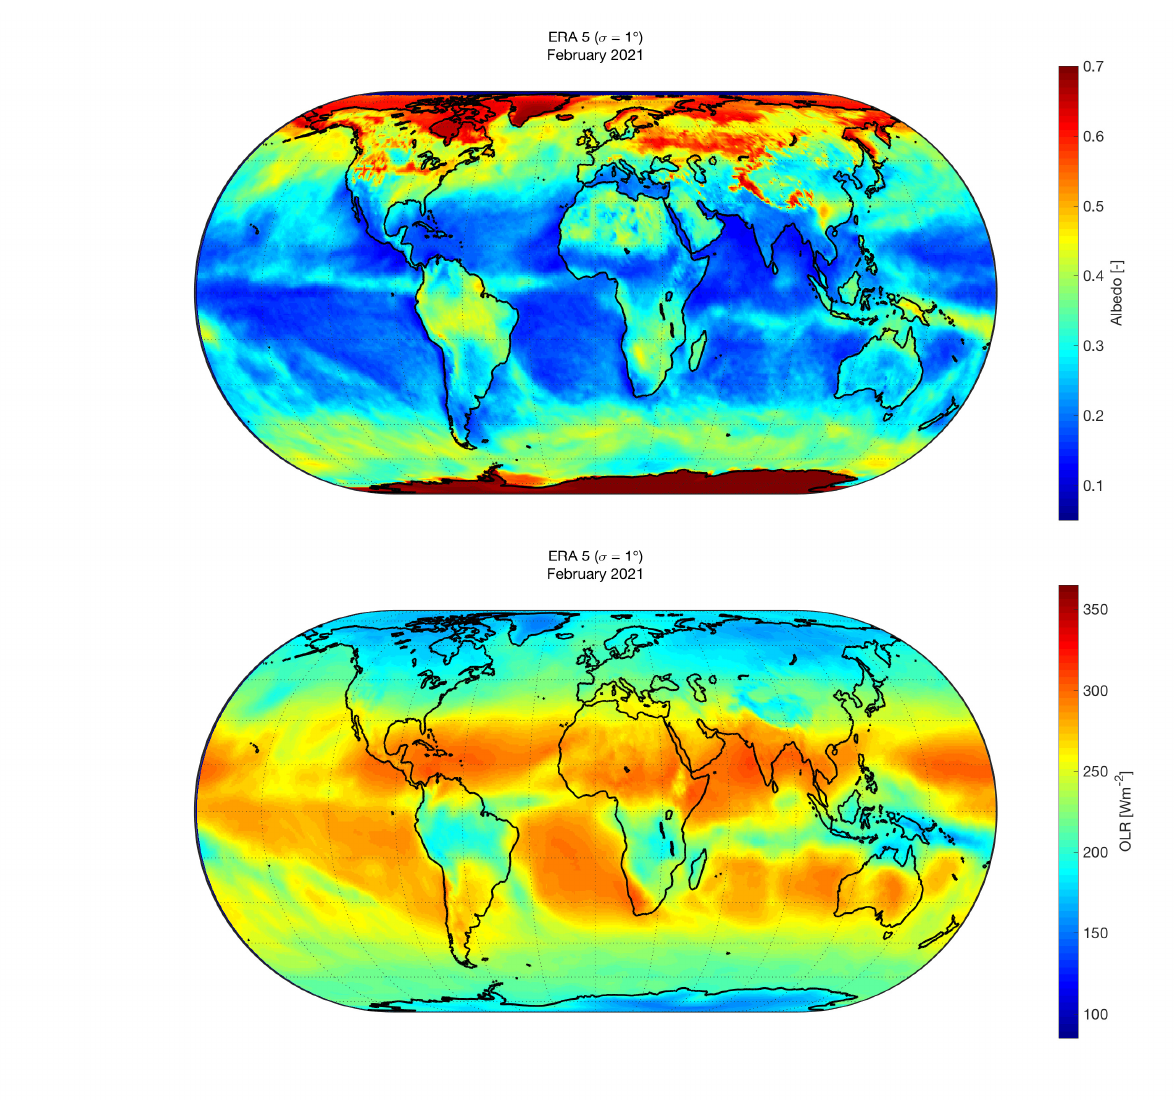
Figure 9. ( Top ) Albedo from ERA 5 during the month of February 2021. ( Bottom ) OLR from ERA5 during the month of February